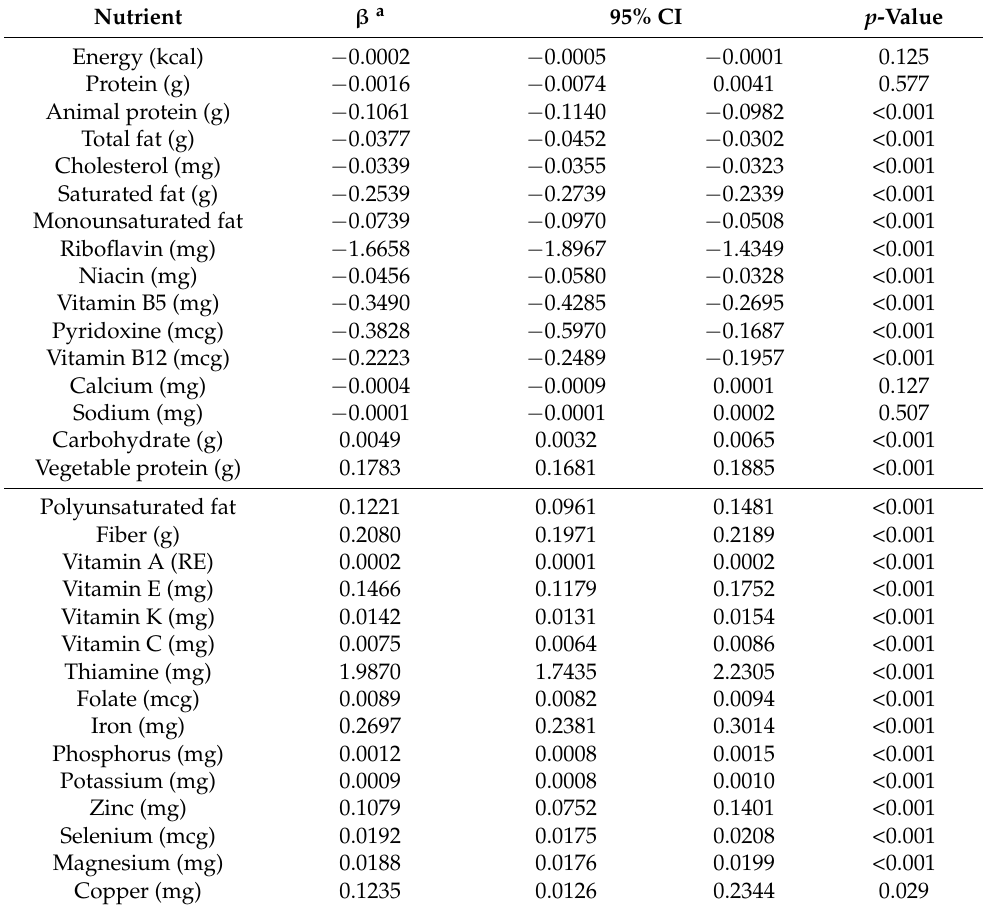
Table 3. Association between PHDI and nutrients. ELSA-Brasil, 2008–2009.